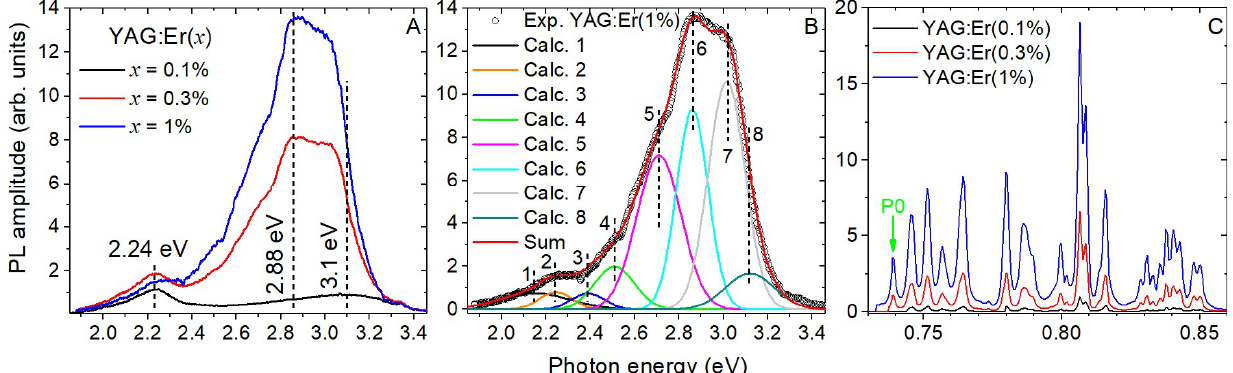
Figure 4. ( A ) PL spectra measured at 296 K under the 340 nm (3.65 eV) LED excitation in the YAG:Er (0.1%, 0.3% and 1%) samples. ( B ) Experimental PL spectrum of YAG:Er (1%) deconvoluted into Gaussian components (calculated peaks 1–8 as listed in the legend). ( C ) IR PL spectrum measured under 980 nm (1.27 eV) LED excitation in the YAG:Er (0.1%, 0.3% and 1%) samples. The pronounced structure is due to the Stark transitions [38]. Peak P0 is missing in the IR PL in YAG:Er (1%).